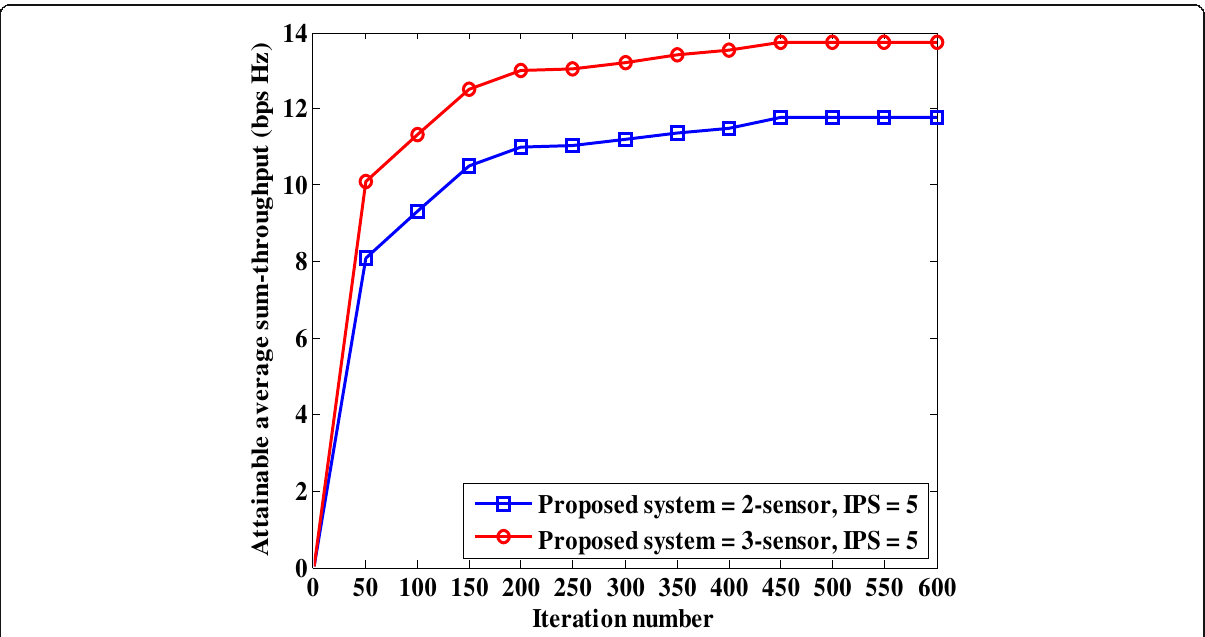
Fig. 4 Attainable average sum-throughput of the system versus iteration